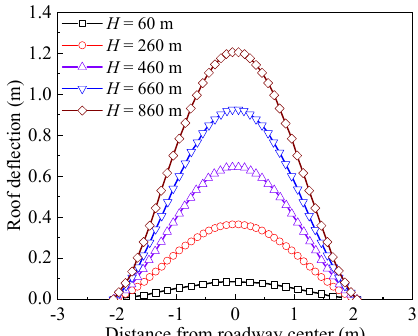
Figure 9. Relation between deflection of composite roof and buried depth of roadway.